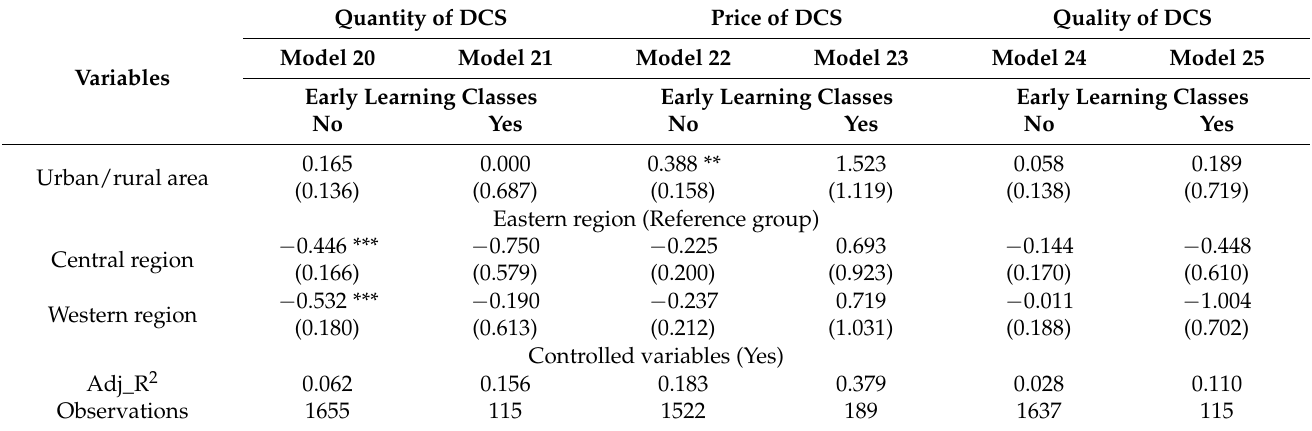
Table 5. The moderating effect of the current status of